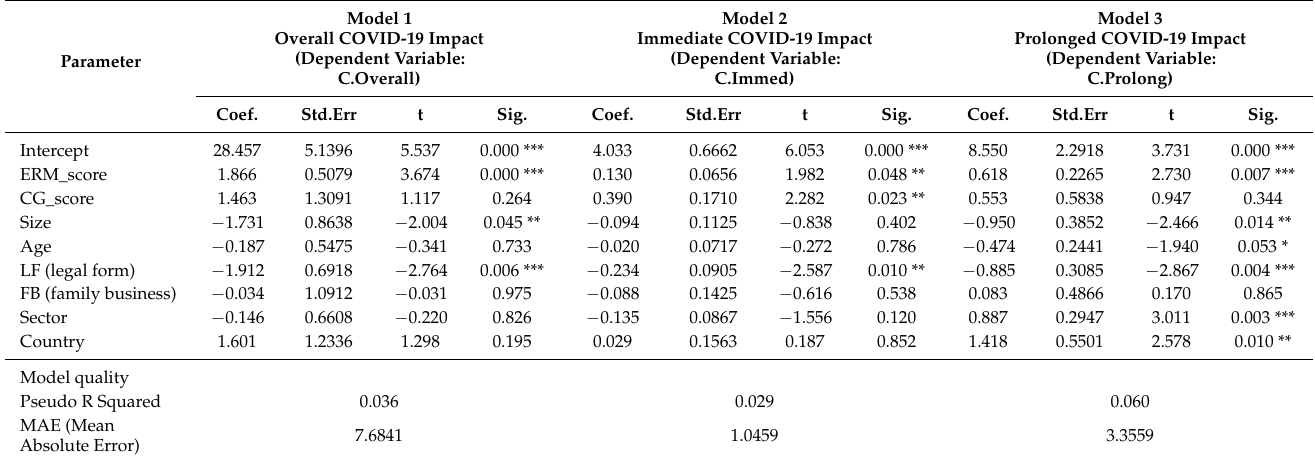
Table 11. Parameter estimates of quantile regression (q = 0.5) for COVID-19